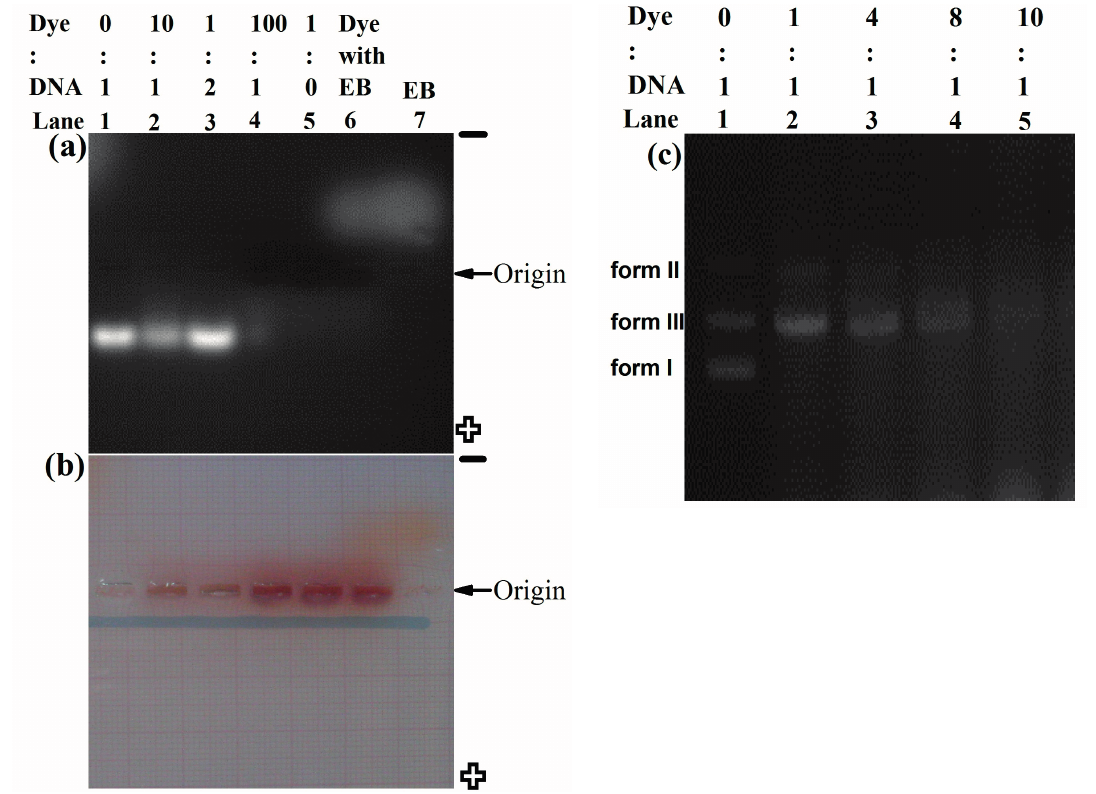
Figure 4. Gel electrophoresis study. ( a ) lane 1 calf thymus DNA without dye, lane 2 ([dye]:[DNA] = 10:1), lane 3 ([dye]:[DNA] = 1:2), lane 4 ([dye]:[DNA] = 100:1), lane 5 Bromide. ( b ) Visual picture of (a). ( c ) Gel with plasmid DNA (pUC 18) and dye. Lane 1 plasmid DNA without dye, lane 2 ([dye]:[DNA] = 1:1), lane 3 ([dye]:[DNA] = 4:1), lane 4 ([dye]:[DNA] = 8:1), lane 5 ([dye]:[DNA] =